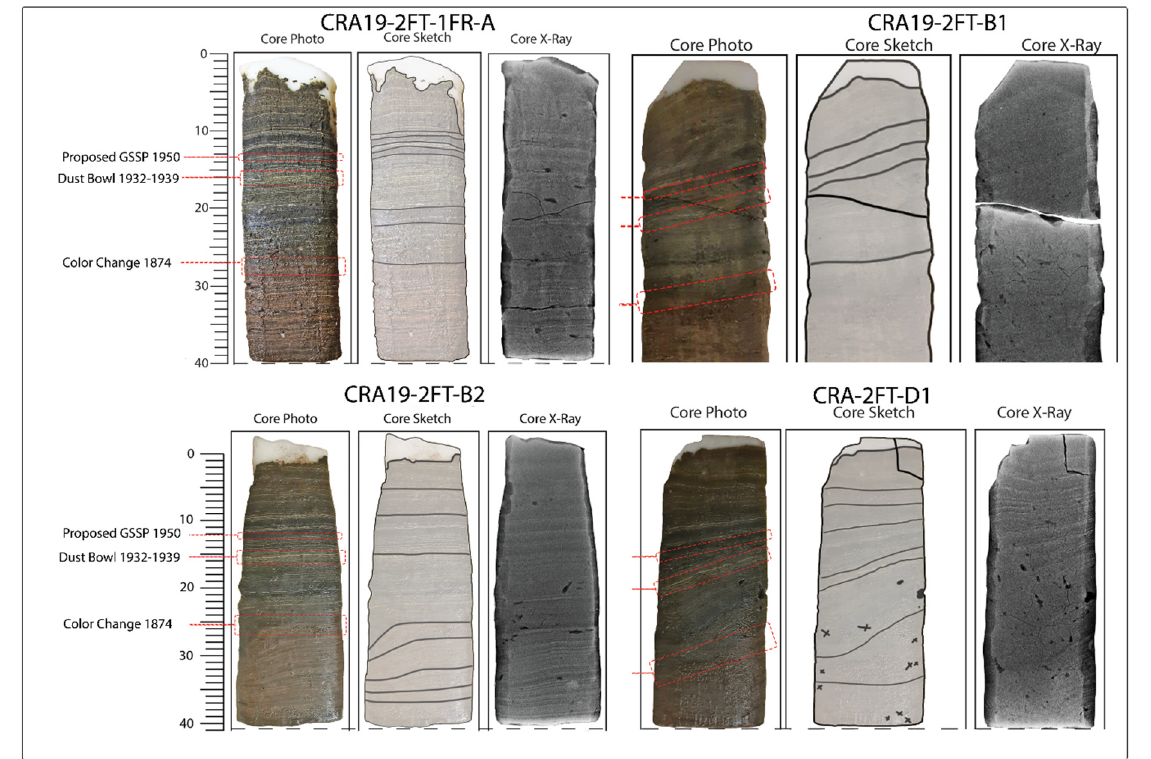
Figure 5. Log cards for core CRA19-2FT-B2 used in this study along with three others from the deep basin of Crawford Lake. Features such as the Dust Bowl, color change resulting from eutrophication associated with logging, and proposed Anthropocene GSSP, are highlighted here to show the ease of identification with basic imaging. Adapted with permission from [30] McCarthy et al., in press / 2023.